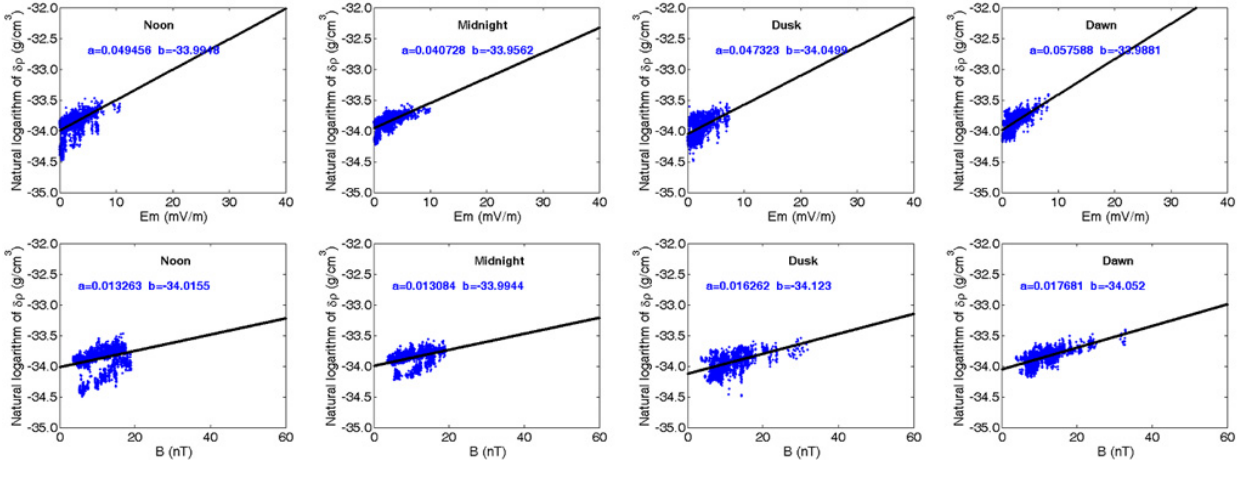
Fig. 17. Same as Fig. 16, but for CIR storms studied. Table 4. Linear control factor of E m and B on ln 1ρ , a E